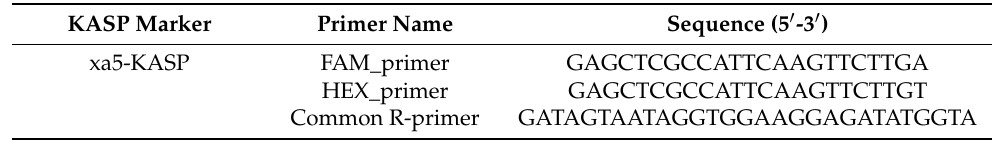
Table 4. List of the primers of the xa5 -KASP marker.